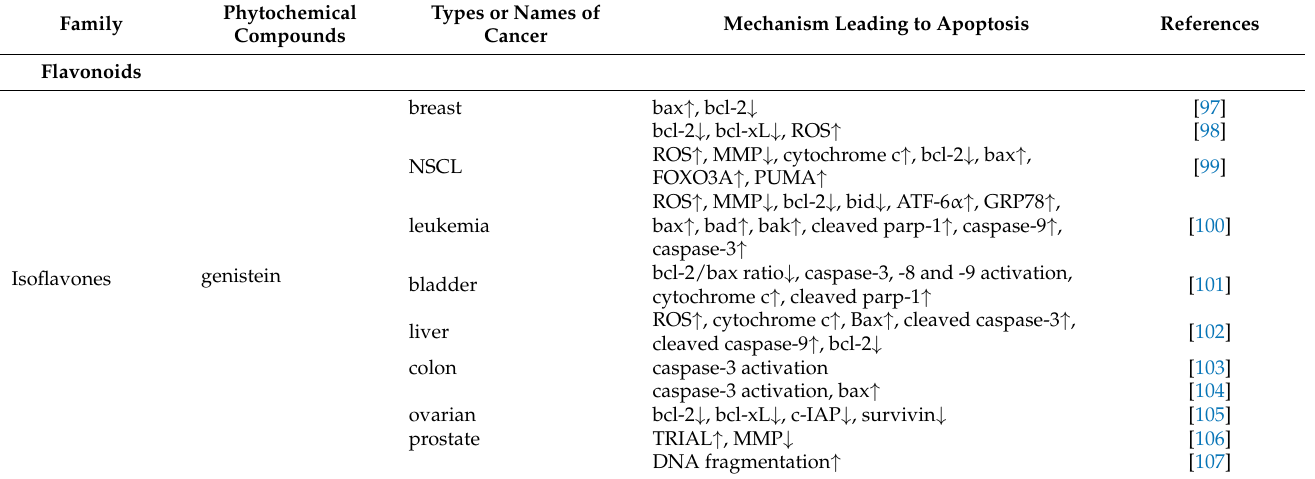
Table 1. Apoptotic mechanisms induced by some representative flavonoid and non-flavonoid family members in cancer. ↓ : decrease, ↑ : increase; NSCL: non-small cell lung cancer; HNSCC: head and neck squamous cell